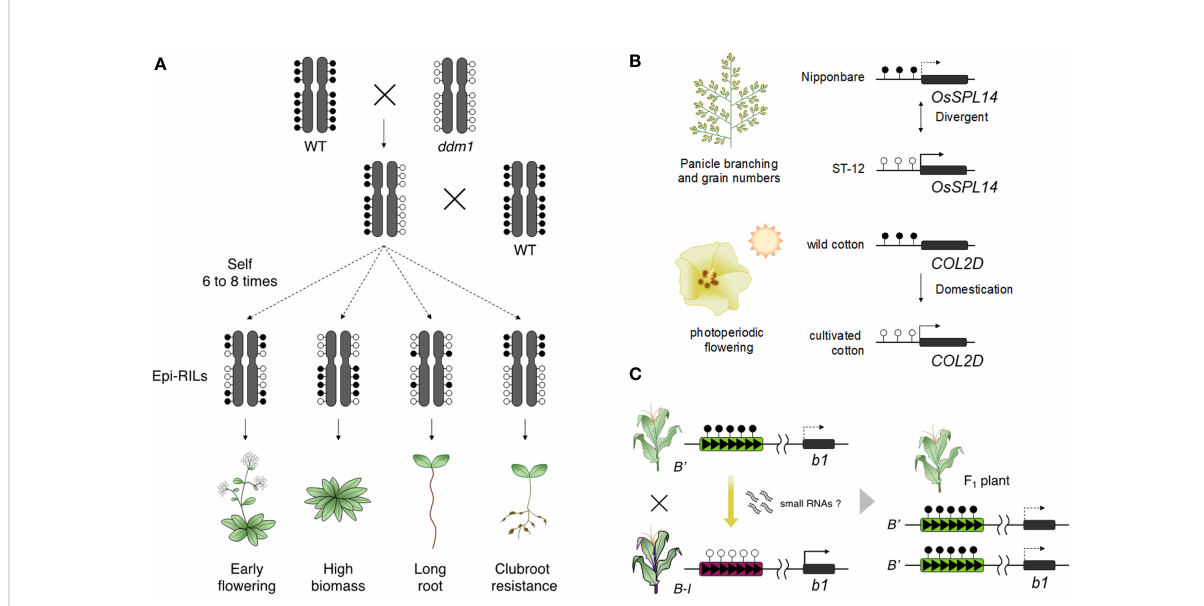
FIGURE 2 Epigenetic changes lead to phenotypic diversity. (A) Epi-RILs shows phenotypic changes in agronomic traits such as early fl owering, increased plant growth, root length, and clubroot resistance. (B) Naturally occurring epialleles have given phenotypic diversity in crops. The state of the OsSPL14 epiallele leads to differences in grain yield between rice varieties (upper). Cultivated cotton has acquired a trait of photoperiodic fl owering by epigenetic change on COL2D during the domestication process (lower). (C) Paramutation of the b1 locus is established by the trans-acting epigenetic effect from a paramutagenic allele (B ’ ) to a paramutable allele (B-I) and contributes to the phenotypic change in their